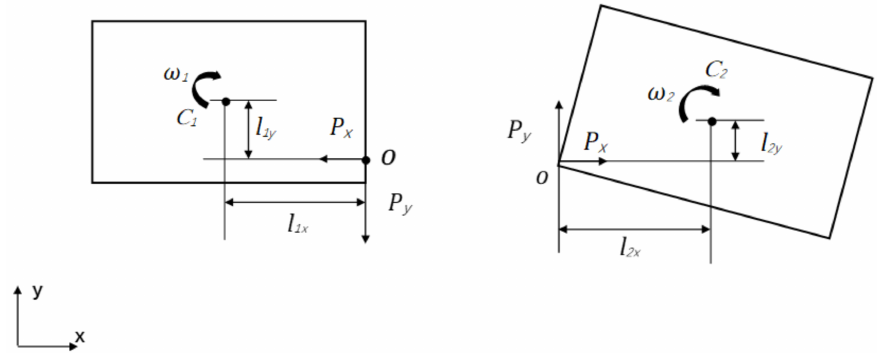
Figure 1. Two-dimensional point collision dynamics model.